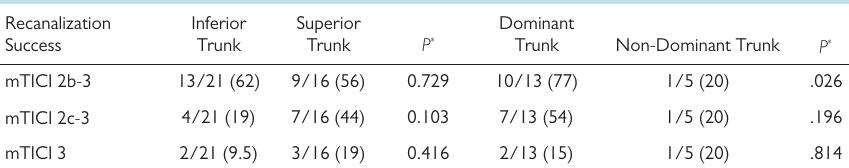
Table 4. Recanalization Results Dependent on Stent Retriever Placement in M1 Occlusion at Second Pass of Thrombectomy Recanalization